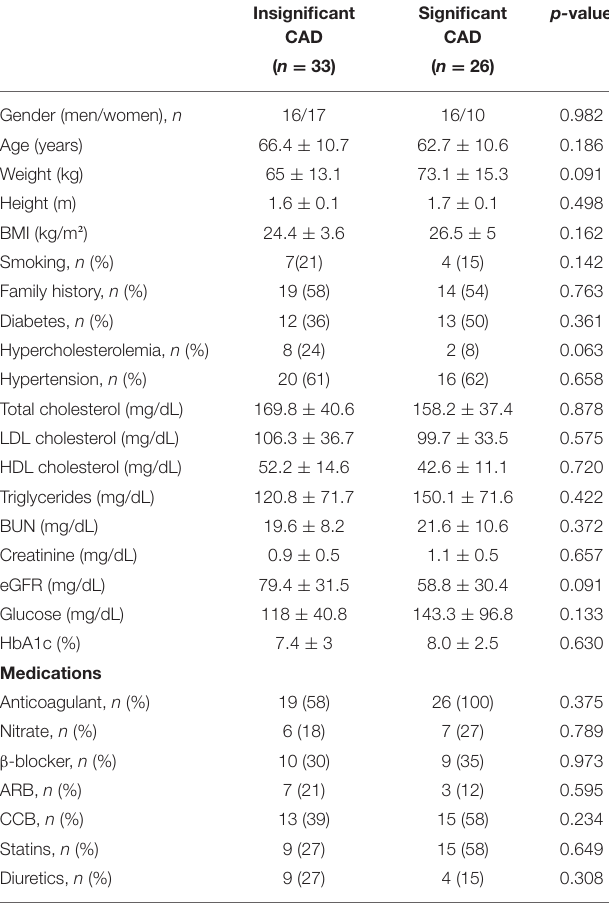
TABLE 1 | Comparison of patient characteristics data in the insignificant and significant CAD groups. Insignificant